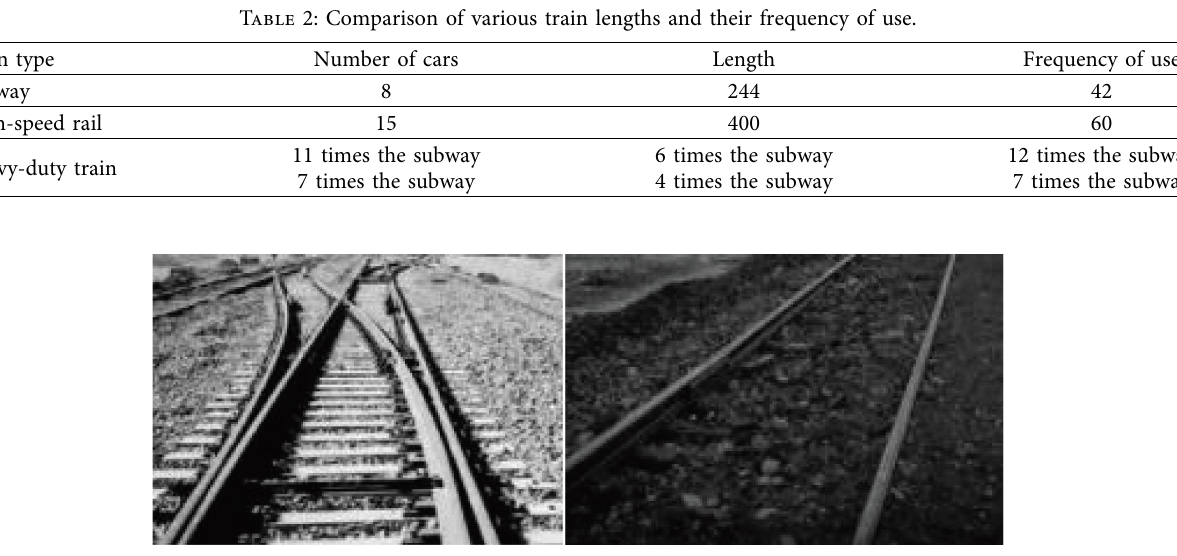
Figure 4: Comparison of ordinary railways and heavy-duty coal railways. Table 3: Types of diseases in heavy-duty railway